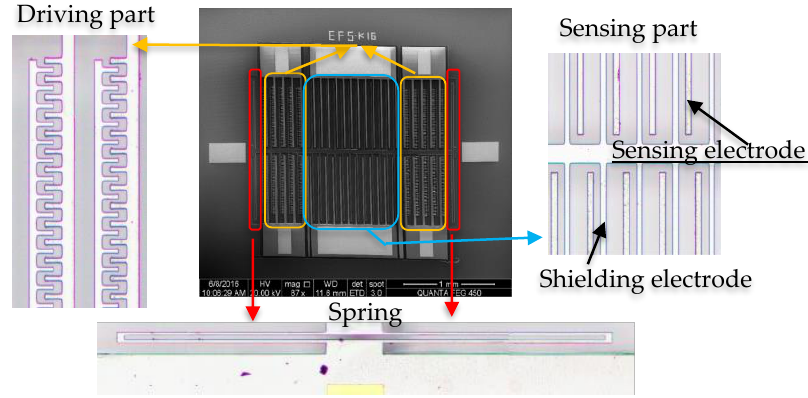
Figure 1. The structure of an electric field sensor based on MEMS technology.